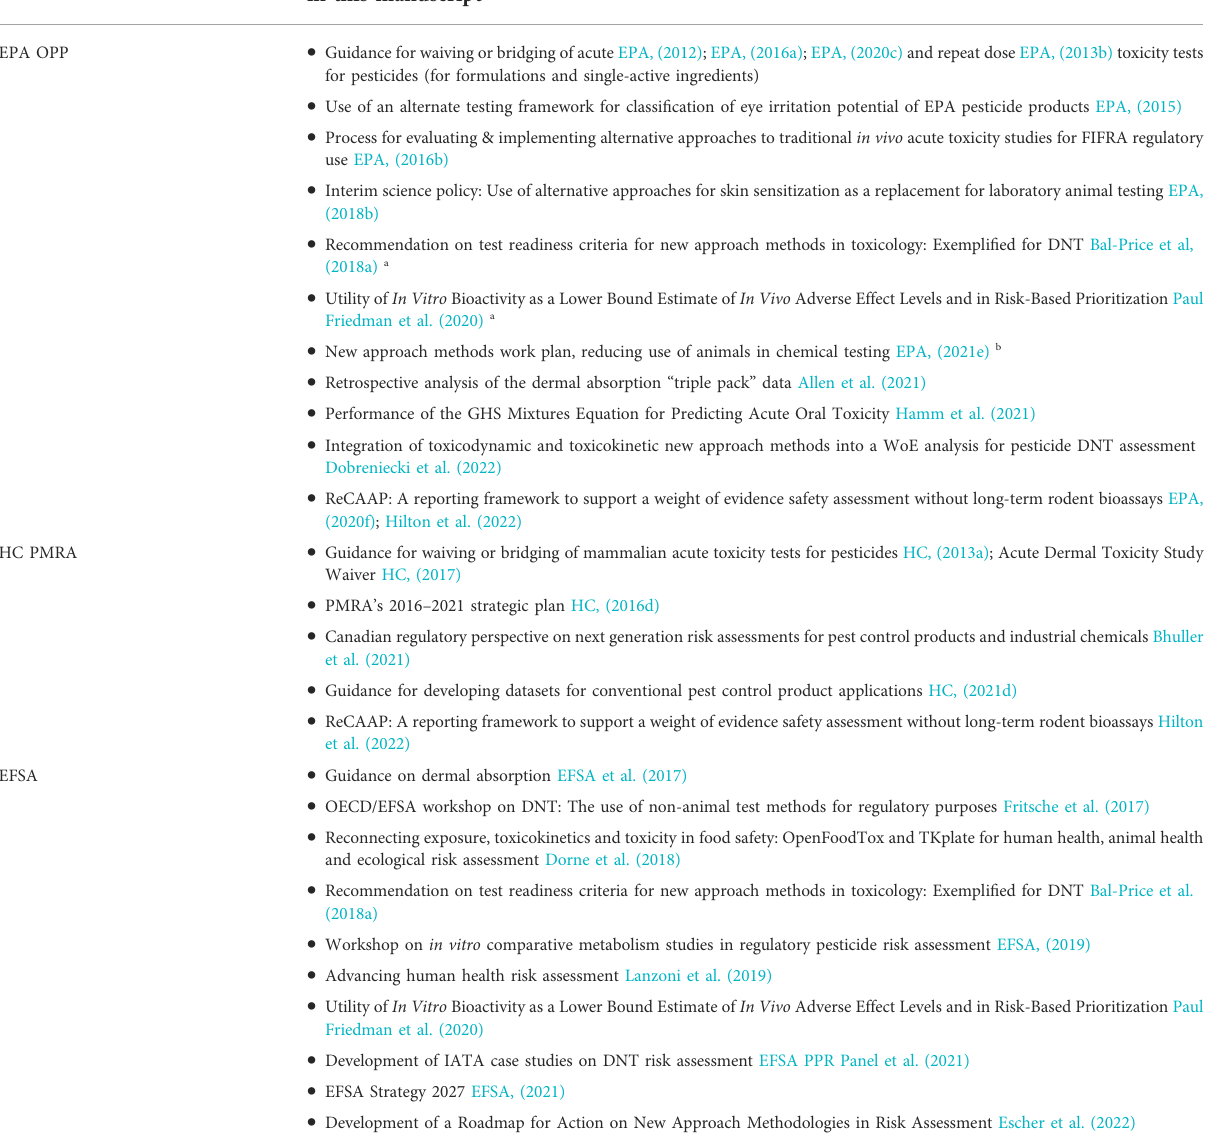
TABLE 2 US, Canada, and EU: pesticides and plant protection products. Agency Strategic plans, guidance, and other documentation for the implementation of NAMs referenced in this manuscript EPA